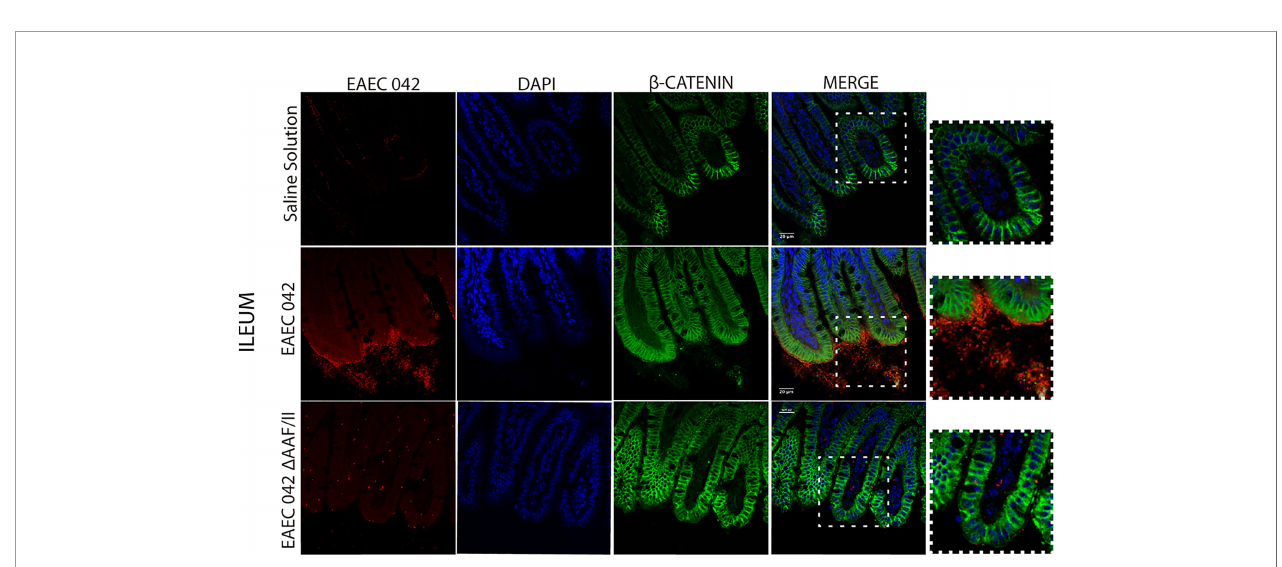
FIGURE 7 | Immuno fl uorescence of b -catenin in ileum at 4 days post-infection. b -Catenin was stained with a secondary antibody conjugated with Alexa 480 antibody (green), bacteria with a primary antibody against EAEC 042 AAF/II and as secondary antibody Alexa 568 (red), and nucleic acids with DAPI